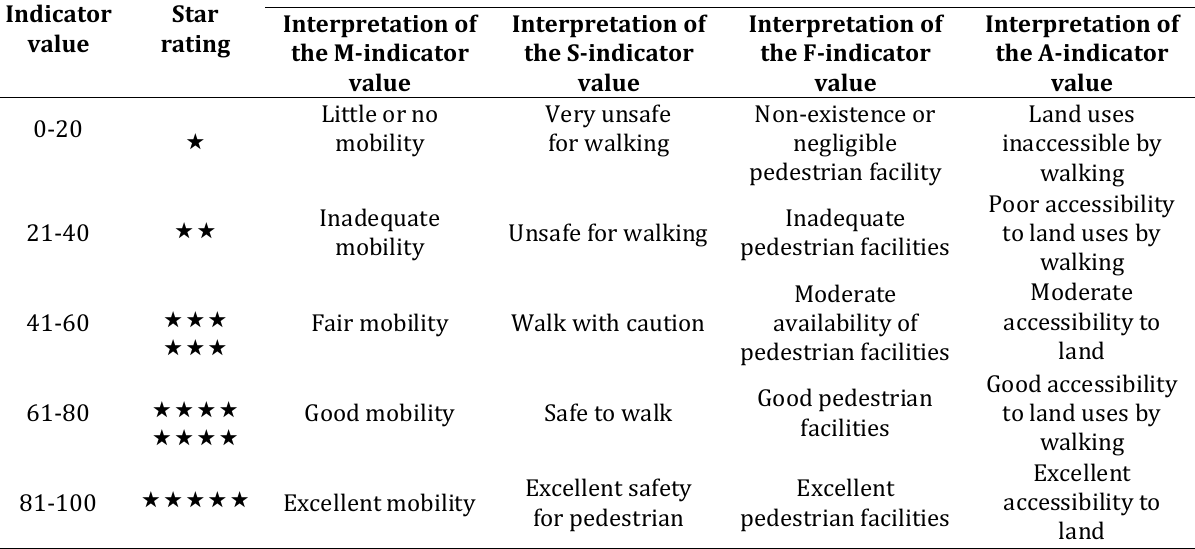
Table 2: Summaries of the interpretation of the mobility (M), safety (S), facility (F), and accessibility (A) indicator values and their corresponding star rating